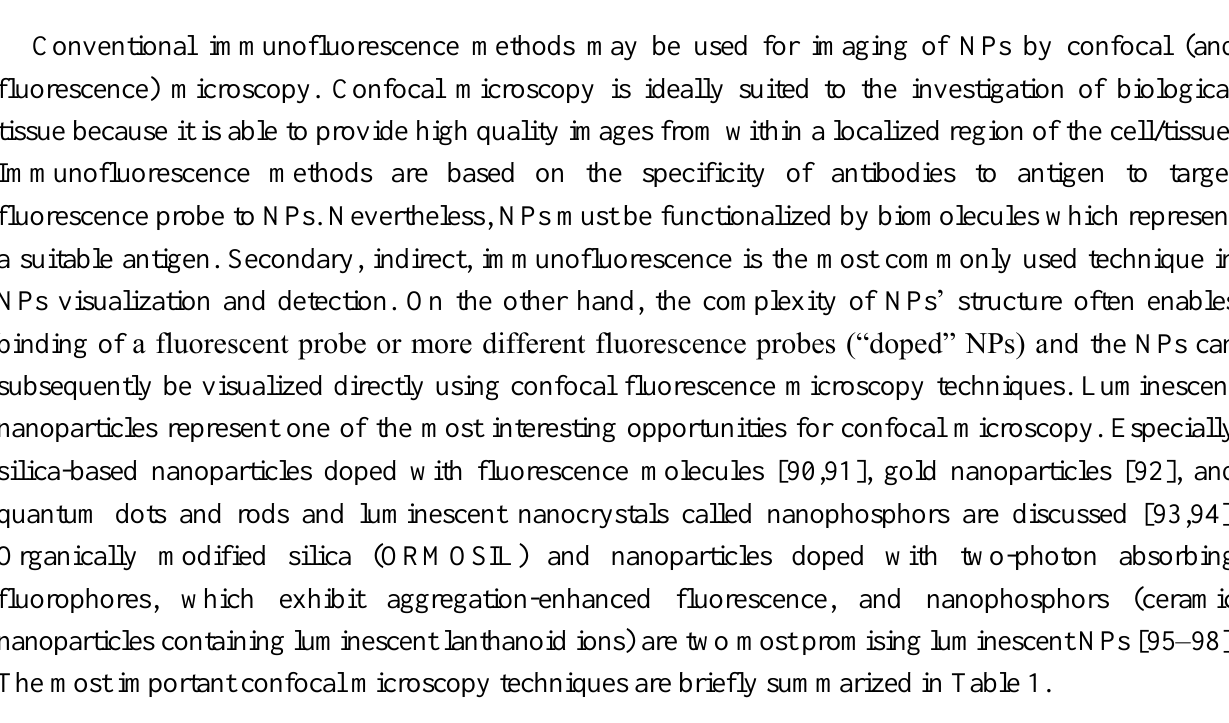
Table 1. The most important confocal microscopy